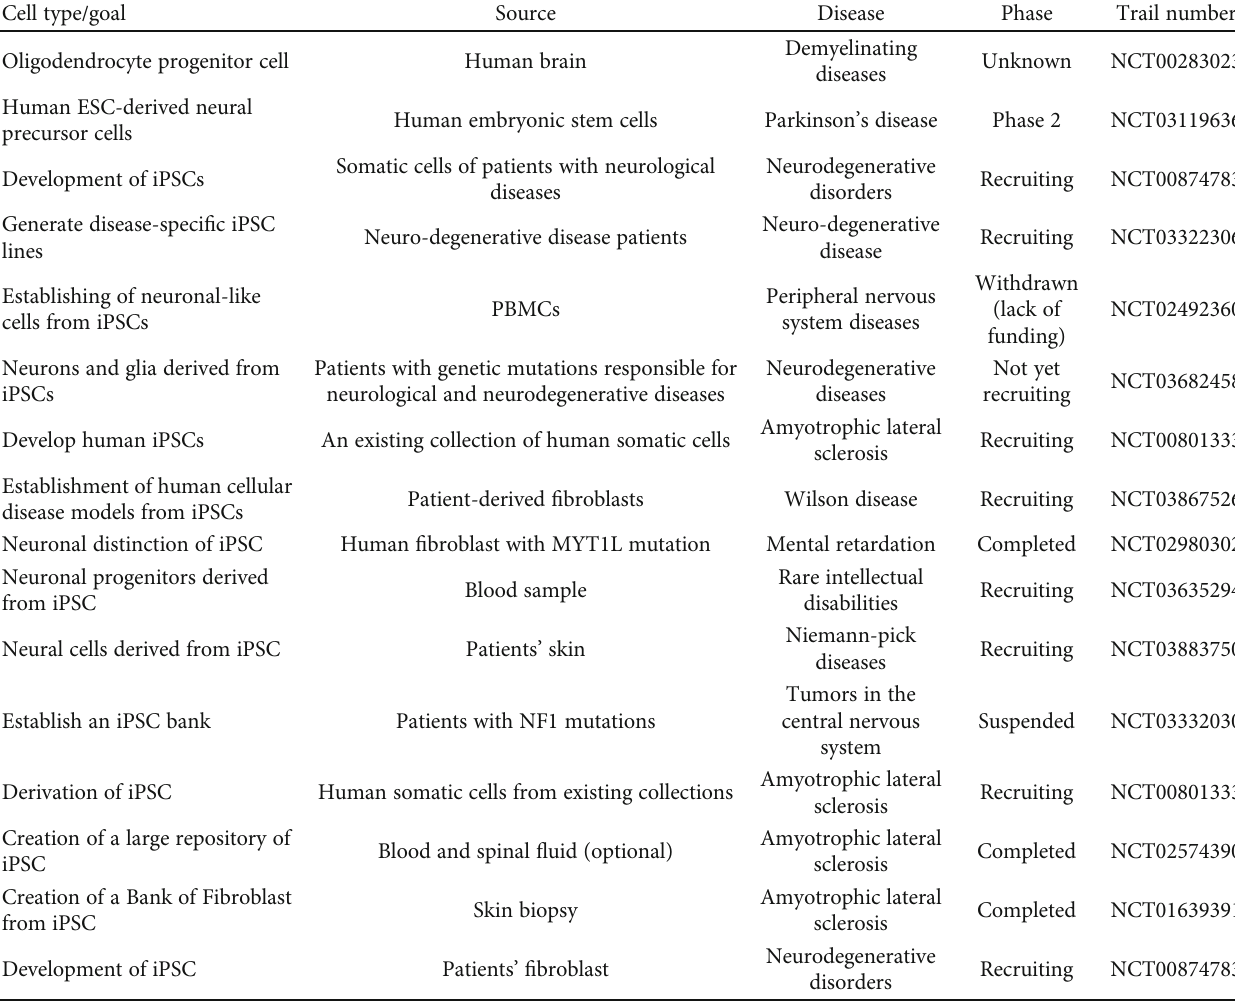
Table 1: iPSCs and ESCs used in clinical trials for the treatment of nerve